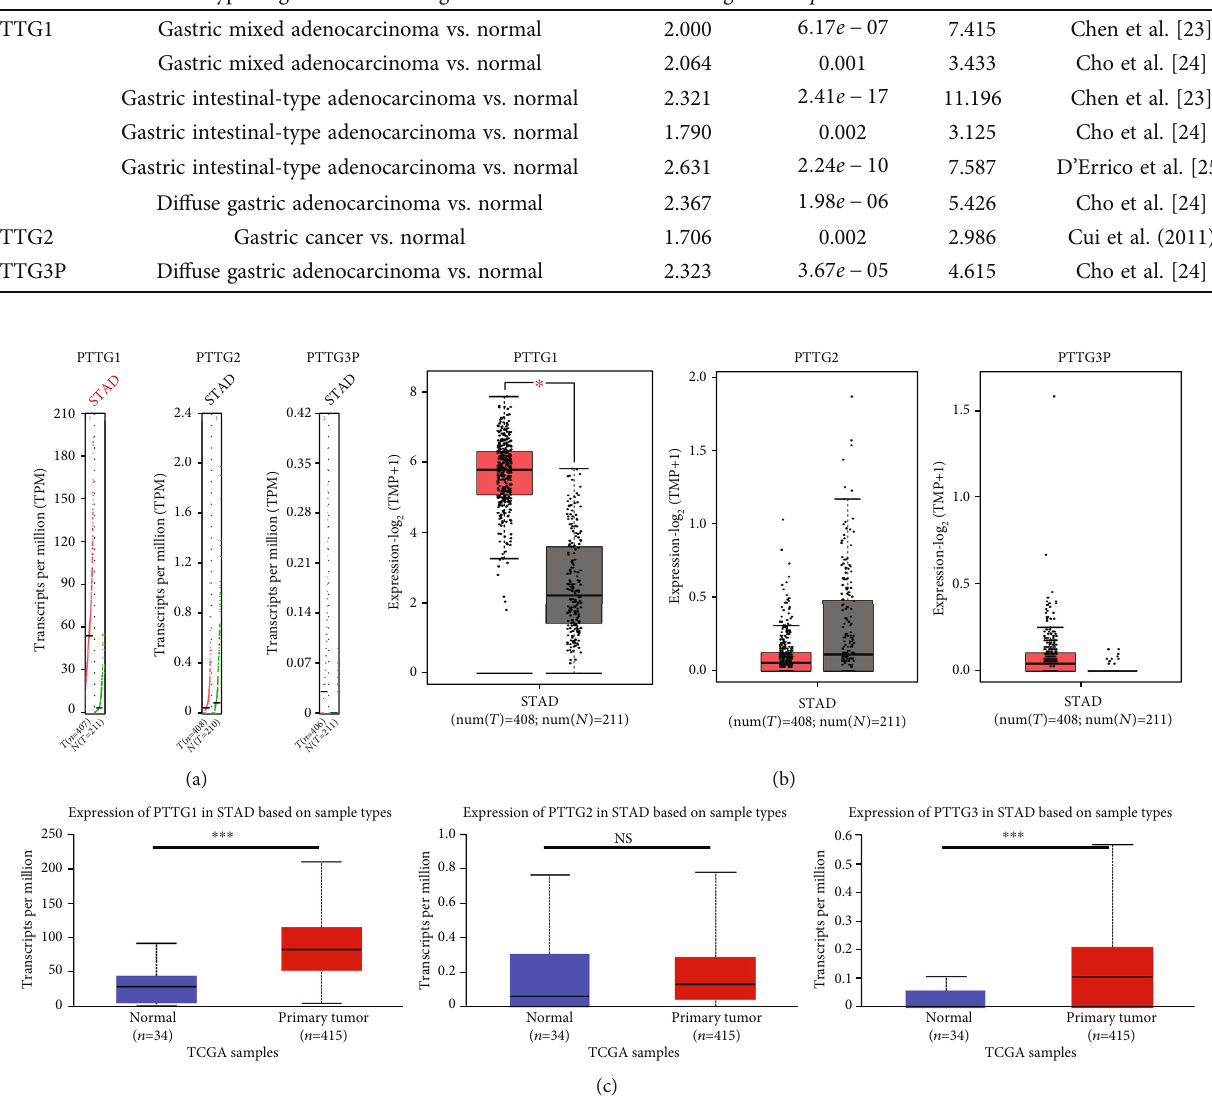
Figure 2: Evaluation of PTTG mRNA expression in STAD tissues against normal stomach tissues (GEPIA2). The mRNA expression of PTTGs was compared in STAD tissues and healthy controls using a scatter diagram (a) and a box plot (b). The false discovery rate (FDR) technique was used to adjust for multiple testing. The following conditions were established: We found a signi fi cant correlation between the two sets of data ( p = 0 : 01 , j log 2 FC j = 1 ), indicating that normal data from TCGA and GTEx patients are similar. (b) Tumor tissues are shown in red, whereas normal tissues are shown in grey. There is statistically signi fi cant di ff erence between (a) and (b), as shown by the pink STAD and ∗ , respectively. T: tumor samples; N: normal samples; STAD: stomach adenocarcinoma; TPM: transcripts per million. (c) Comparison of PTTG expression between STAD and healthy tissues (UALCAN).